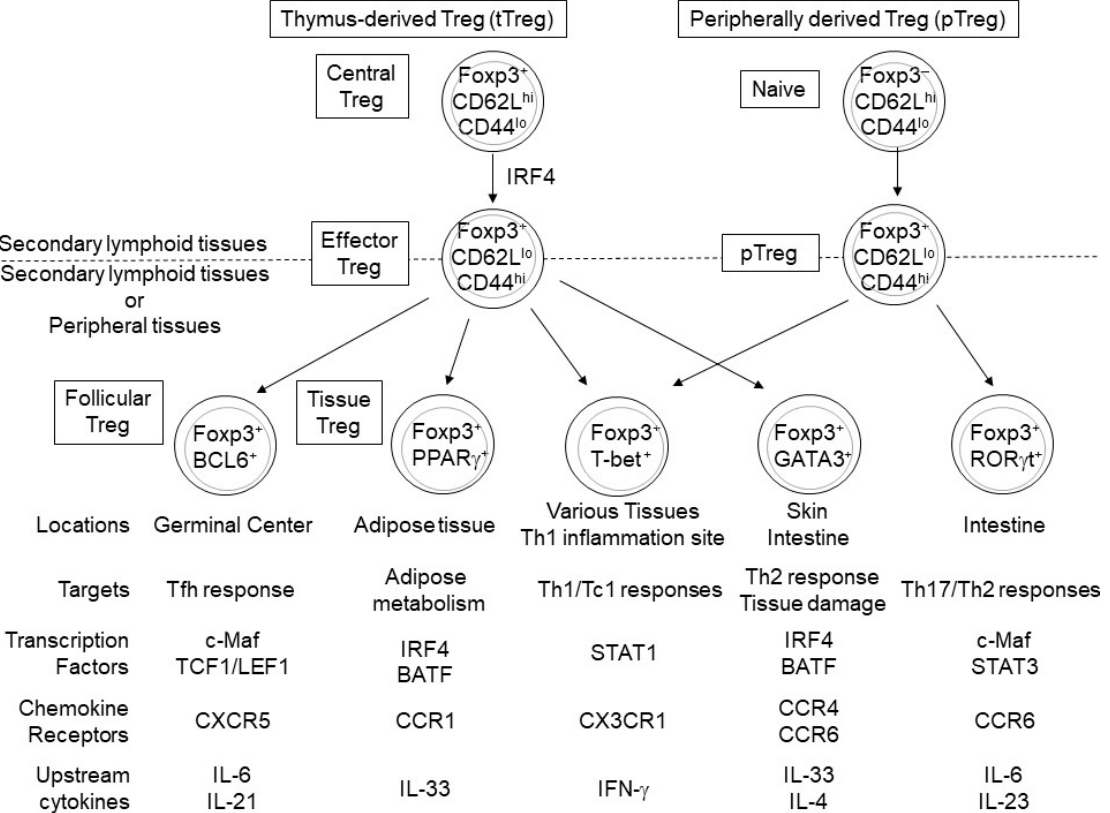
Figure 2. Peroxisome-proliferator-activated receptor γ (PPAR γ ), B cell lymphoma 6 (BCL6), T-bet, GATA-binding protein 3 (GATA3), and ROR γ t regulate the differentiation and function of tissue Treg cells derived from eTreg and peripherally derived Treg (pTreg) cells. Treg cells expressing PPAR γ , BCL6, or GATA3 mainly differentiate from tTreg cells, while ROR γ t + Treg cells differentiate from naïve CD4 + T cells [34–36,43,44] and T-bet + Treg cells likely differentiate from both eTreg and pTreg cells [45–47] . These tissue-specific Treg subsets express different functional molecules and play different roles in maintaining tissue homeostasis by suppressing specific immune responses and regulating lipid metabolism and tissue repair.